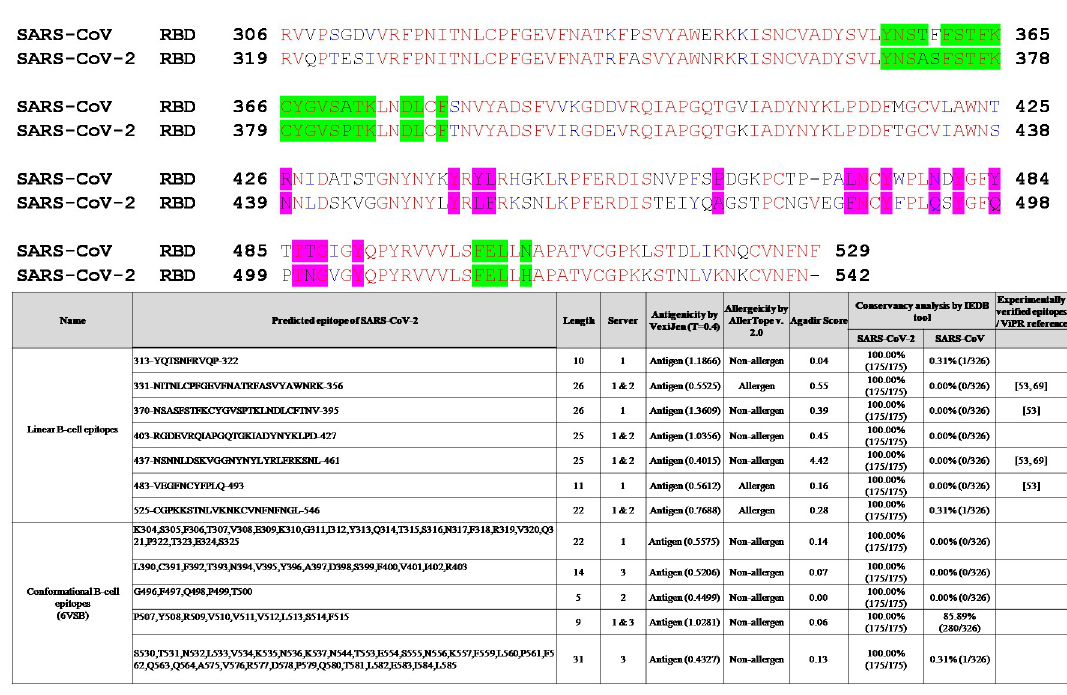
Fig 4. Sequence alignment of receptor-binding domains (RBDs) of SARS-CoV-2 and SARS-CoV spike (S) proteins. GenBank accession numbers of the S protein of SARS-CoV-2 and SARS-CoV are QHR63250.2 (SARS-CoV-2) and AAP30030.1 (SARS-CoV BJ01), respectively. ACE2-binding residues are colored magenta, and CR3022 epitope residues are colored bright green. The alignment was performed using Clustal Omega. The inset table shows the antigenic linear and conformational B-cell epitopes predicted in the RBD of the S protein of